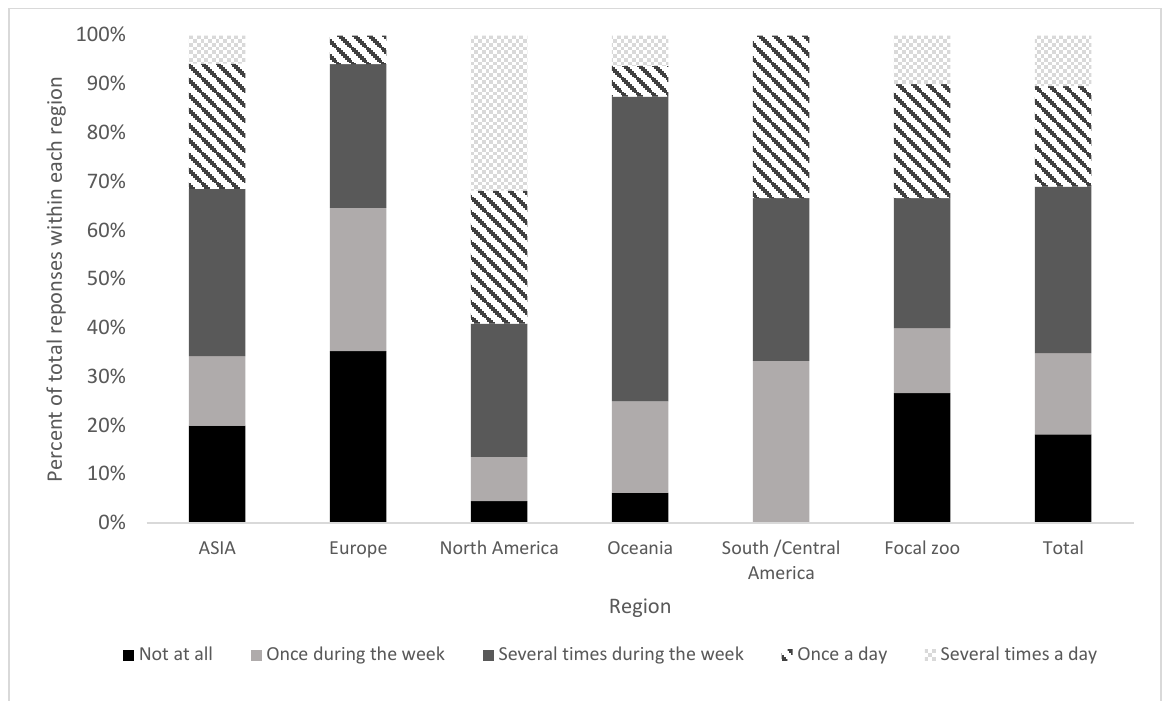
Figure 2. The frequency of cognitive enrichment use within each region, displayed as a percentage of the total responses from each region.